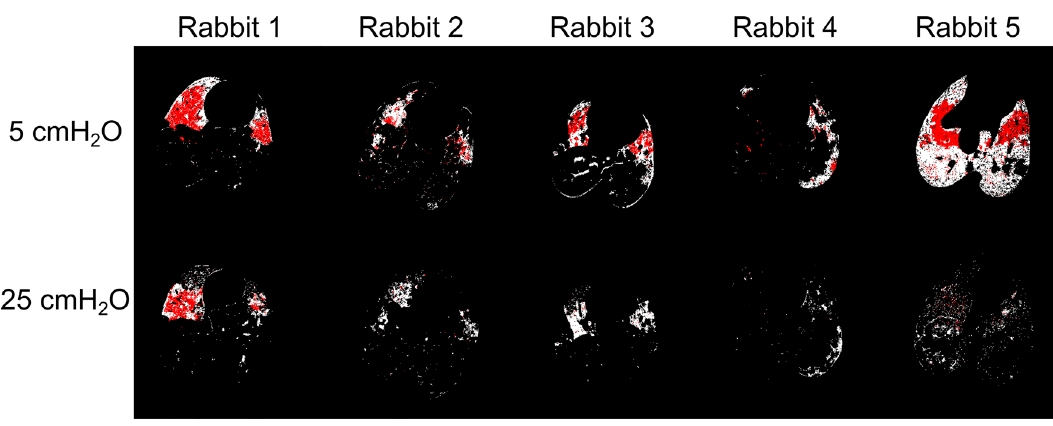
Figure 3. Maps of non-aerated lung regions after injurious ventilation. The maps refer to the static CT images acquired during expiration (5 cmH 2 O, upper panel) and inspiration (25 cmH 2 O, lower panel). White: non aerated regions after injurious ventilation; Red: non aerated regions after injurious ventilation which were already present after saline lavage. A spatial co-localization between non-aerated regions before and after injurious ventilation is visible at a pressure of 5 cmH 2 O. Recruitment of non-aerated regions upon inspiration is visible after saline lavage (lower